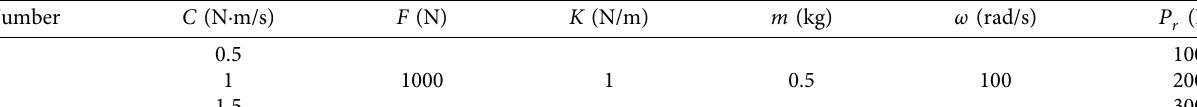
Table 5: Calculation parameters.